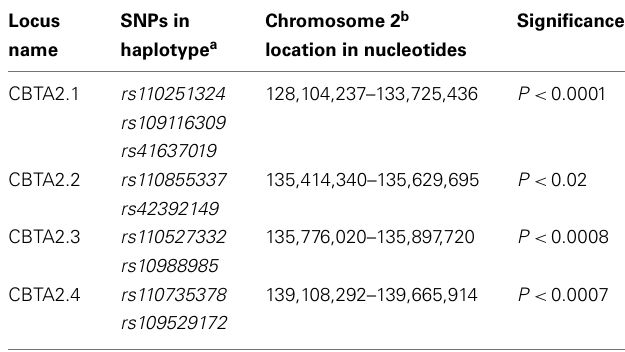
Table 1 | Haplotypes associated with dams of bovine viral diarrhea persistently infected calves on BTA2 using the allelic model.